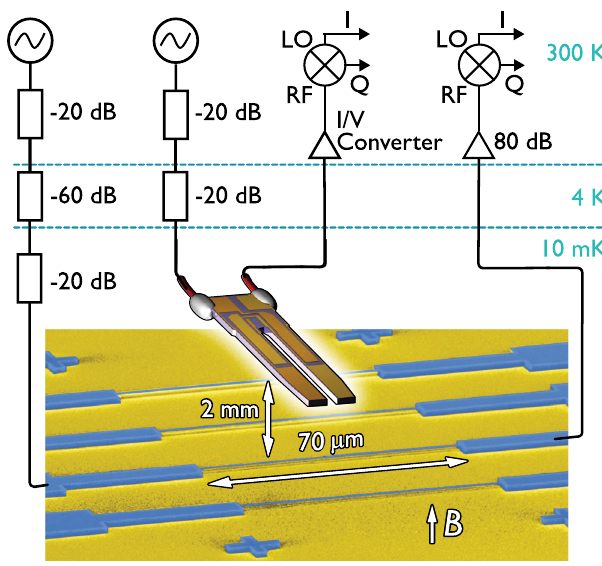
Fig. 1 Schematic of the experimental setup. A tuning fork generates quantum turbulence, whilst a 70- μ m-long nanomechanical beam, suspended 1 μ m above the substrate, acts as the detector. The beam and fork are driven by vector network analysers or signal generators through several stages of attenuation at various temperatures. The beam and fork signals are ampli fi ed at room temperature by an 80-dB ampli fi er and an I/V converter 22 . For a detailed description see the Supplementary